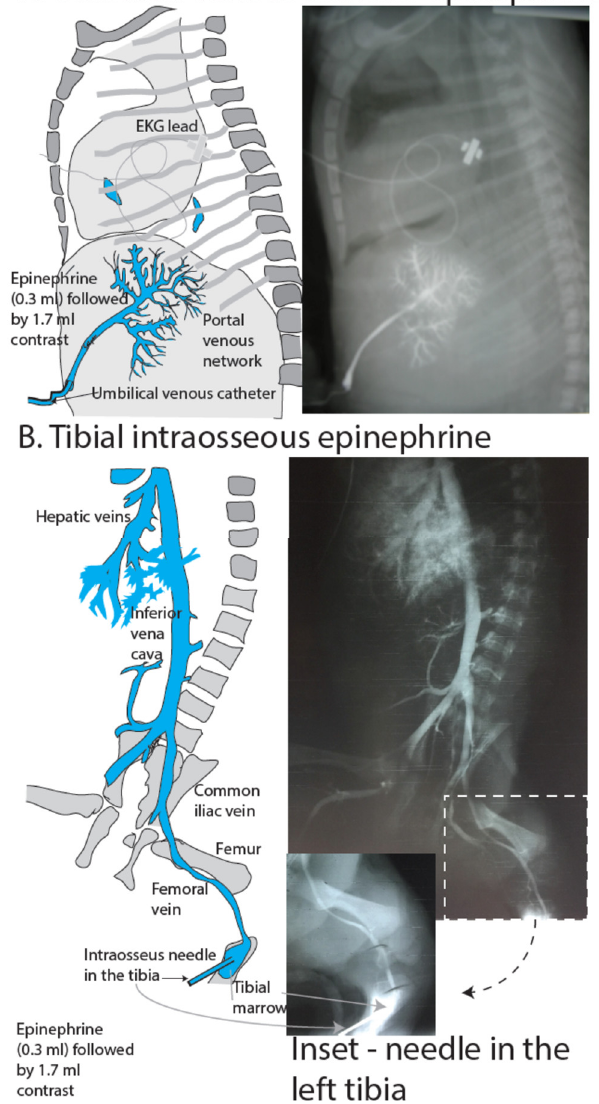
Figure 5. X-ray showing distribution following ( A ) low-lying umbilical venous catheter or ( B ) tibial IO administration of contrast in a perinatal cardiac arrested lamb model following 30 sec of chest compressions. Rapid distribution of contrast into the venous vasculature and heart can be appreciated following IO administration. IO: Intraossesus. Copyright Satyan